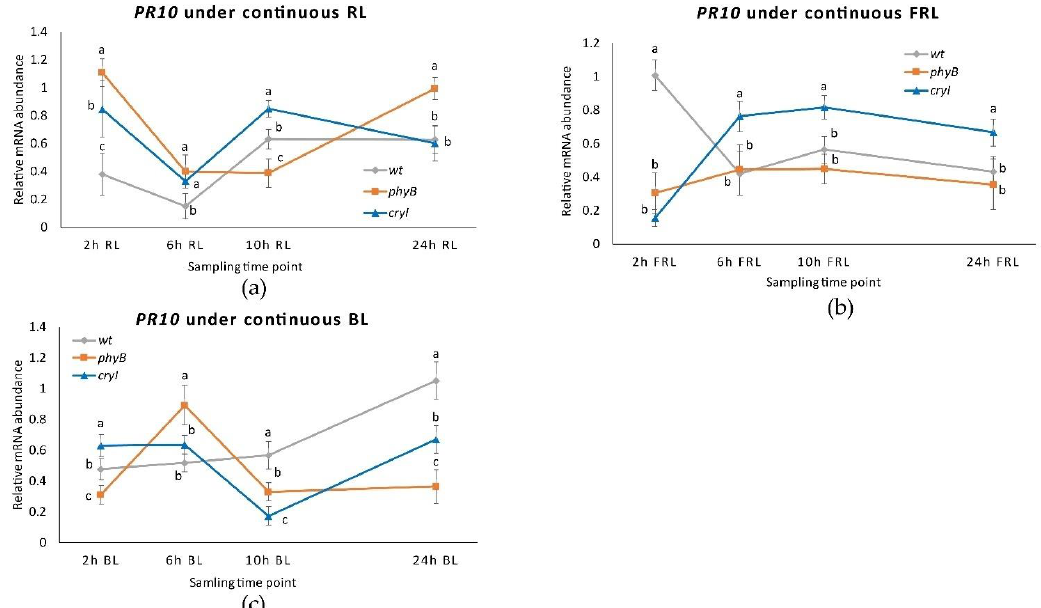
Figure 11. PR10 expression in Dar Gazi-wt , Dar Gazi-phyB , and Dar Gazi-cry1 : ( a ) in 24 h continuous RL, panel; ( b ) in 24 hh continuous FRL, panel; ( c ) in 24 h continuous BL, panel. Results are presented after normalization with ef1A . Data shown are the average of two biological replicates run in triplicate, with error bars representing SD. At each time point values with different letters significantly differ according to the analysis of the variance (ANOVA) and least significant difference (LSD) tests ( p ≤ 0.05).